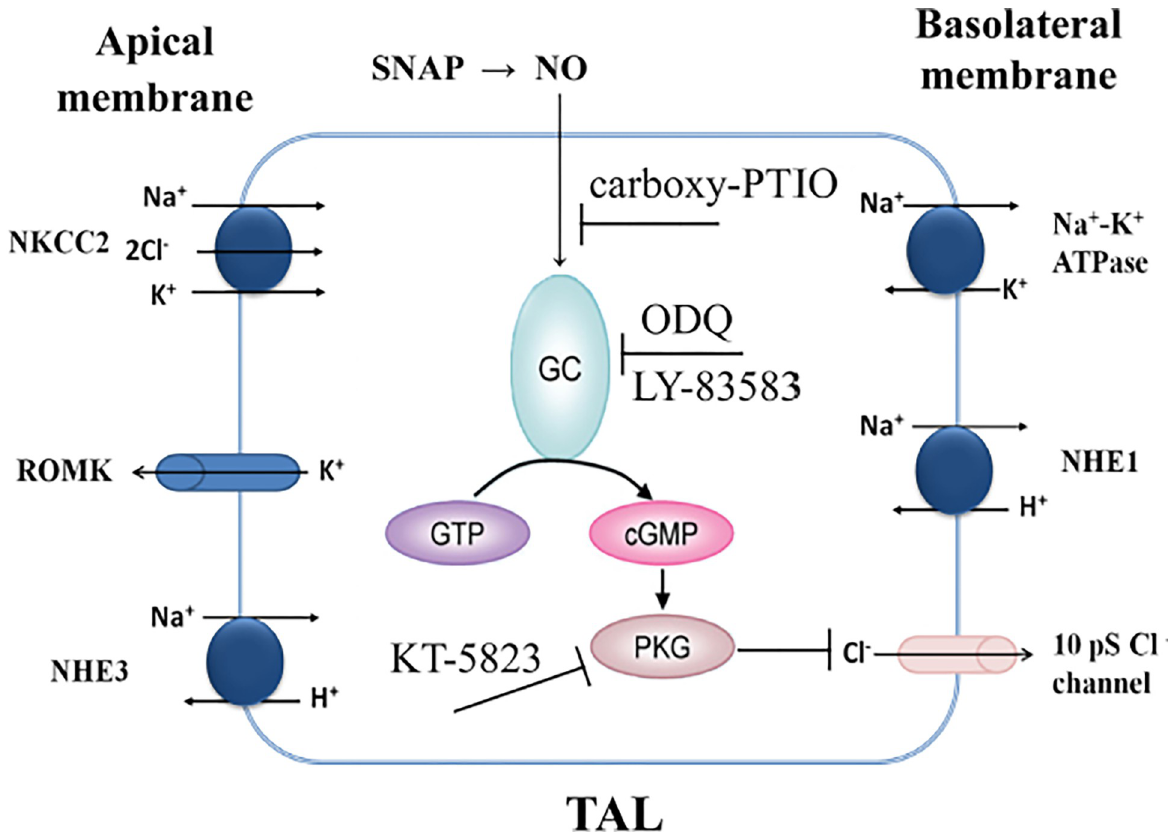
Fig 7. Signaling cascade for Inhibitory effect of SNAP on the 10-pS Cl - channel in TAL. Carboxy-PTIO is a NO scavenger, ODQ or LY-83583 blocks activity of GC, KT-5823 inhibits PKG.